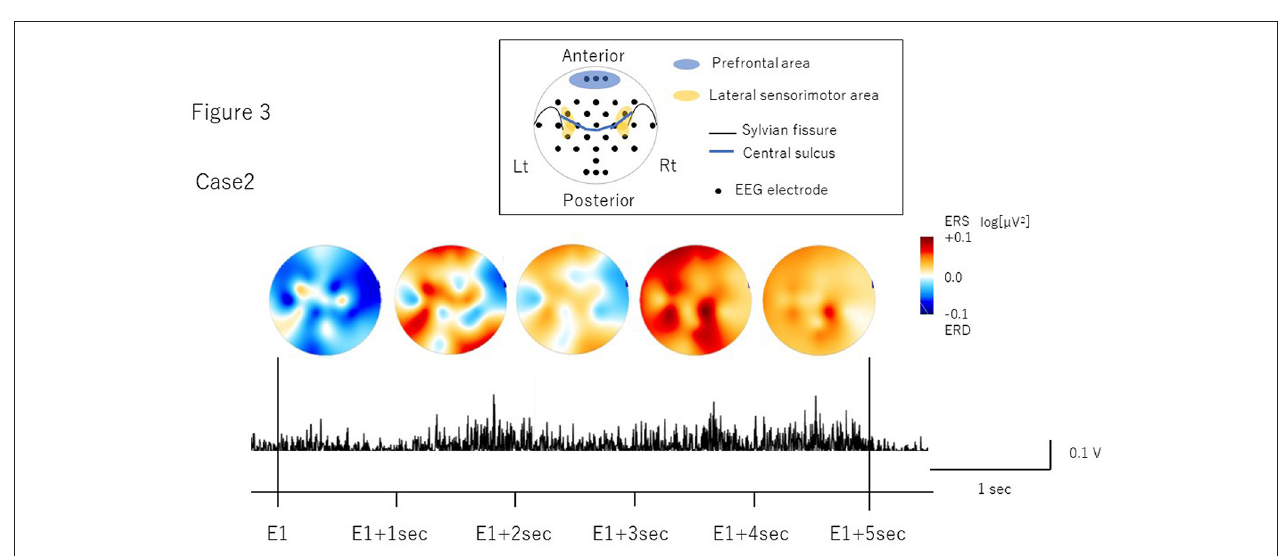
FIGURE 3 | The topographic mapping of the averaged ERD/ERS and the EMG of submental group muscles in Case 2. The topographic mapping display of the swallow-related ERD or ERS every 1s and the EMG of submental group muscles during a single swallow in Case 2 are shown. ERD/S are color-coded on the topomap display. ERD is prominent in the right lateral sensorimotor areas at the beginning of swallowing.